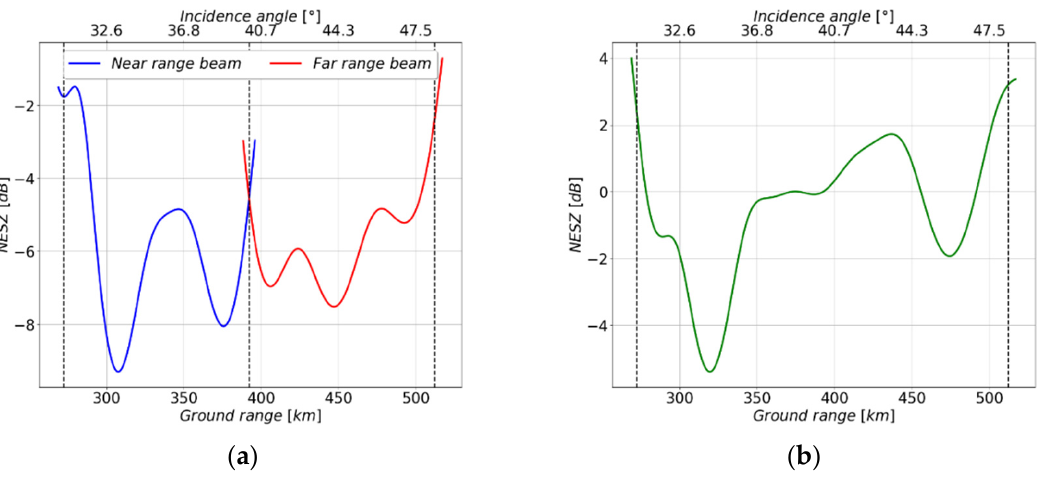
Figure 4. NESZ as function of ground range (incidence angle) for system parameters shown in Tables 2 and 3 and a duty cycle of 20% ( a ) for the near range beam (blue curve) and far range beam (red curve) that image 120 km ground swath each and ( b ) the beam that covers a 240 km ground swath. The 120 km ground swaths and the 240 km ground swath are highlighted.